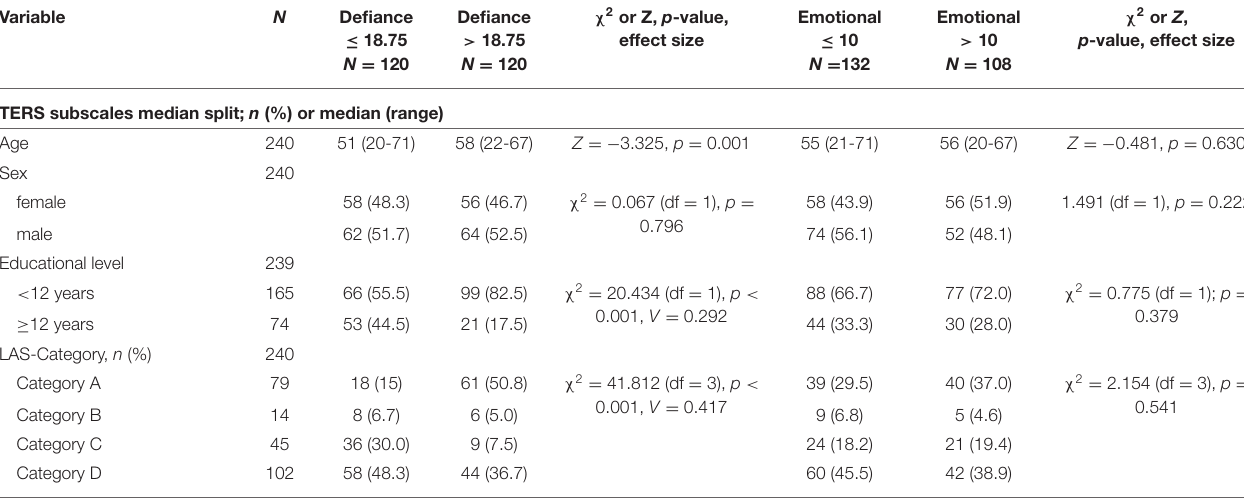
TABLE 3 | Comparison of baseline characteristics divided by the TERS subscales “defiance” and “emotional sensitivity” (median split).